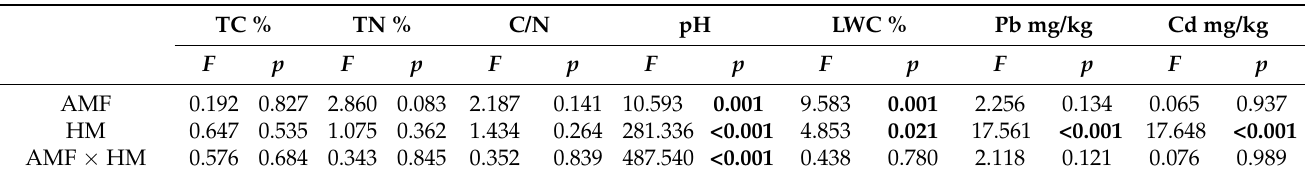
Table 1. The Two-way ANOVA analysis of heavy metal stress and AM fungal infection on litter properties.